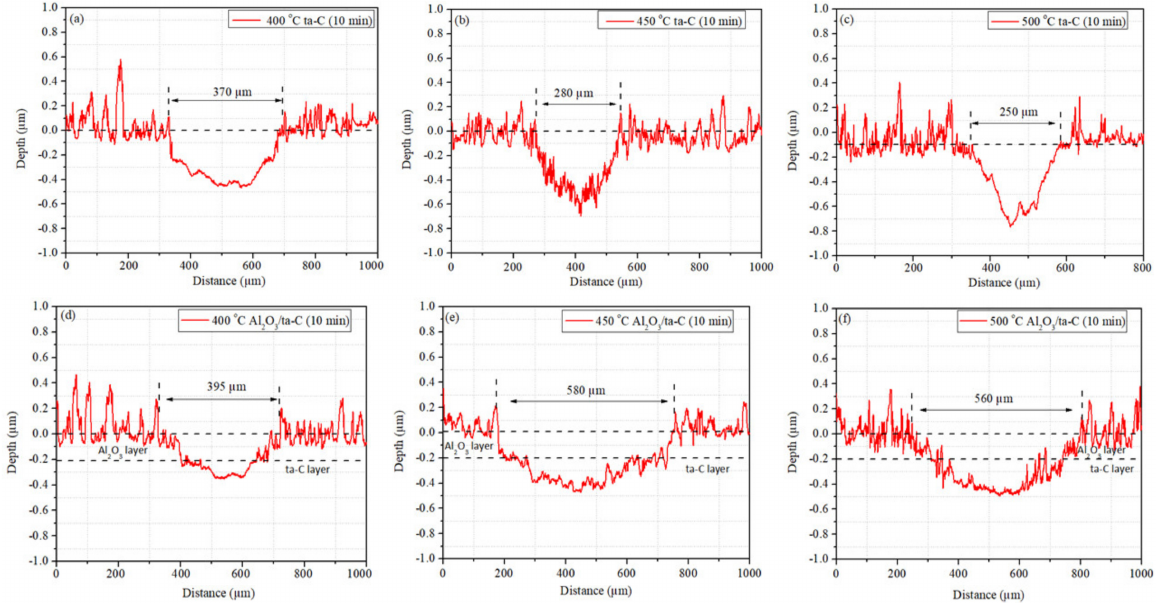
Figure 4. Depth profiles of wear scars observed on the ( a – c ) ta-C and ( d – f ) Al 2 O 3 /ta-C coatings after the sliding tests for 10 min at 400, 450 and 500 ◦